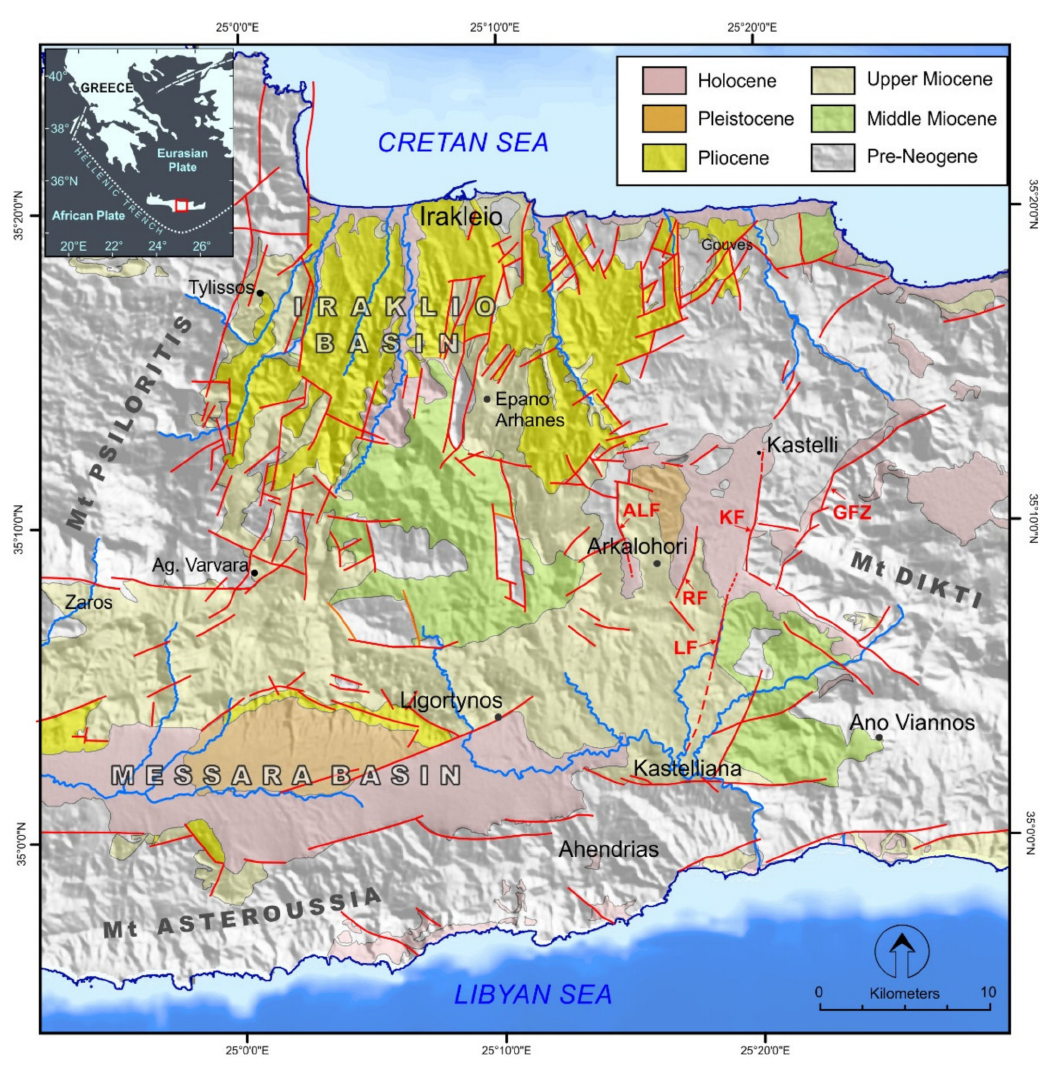
Figure 2. Neotectonic map of the broader Heraklion-Messara basins compiled after the IGME geological map sheets [31–35] and geological mapping of [27,36]. KF: Kastelli Fault; ALF: Arkalochori f.; RF: Roussochori f.; LF: Lagouta F.; GFZ Geraki Fauth